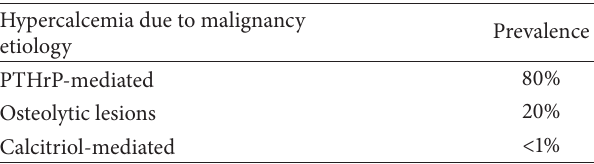
Table 2: The etiologies and frequency of PTH-independent hyper- calcemia related to malignancy [2, 4].